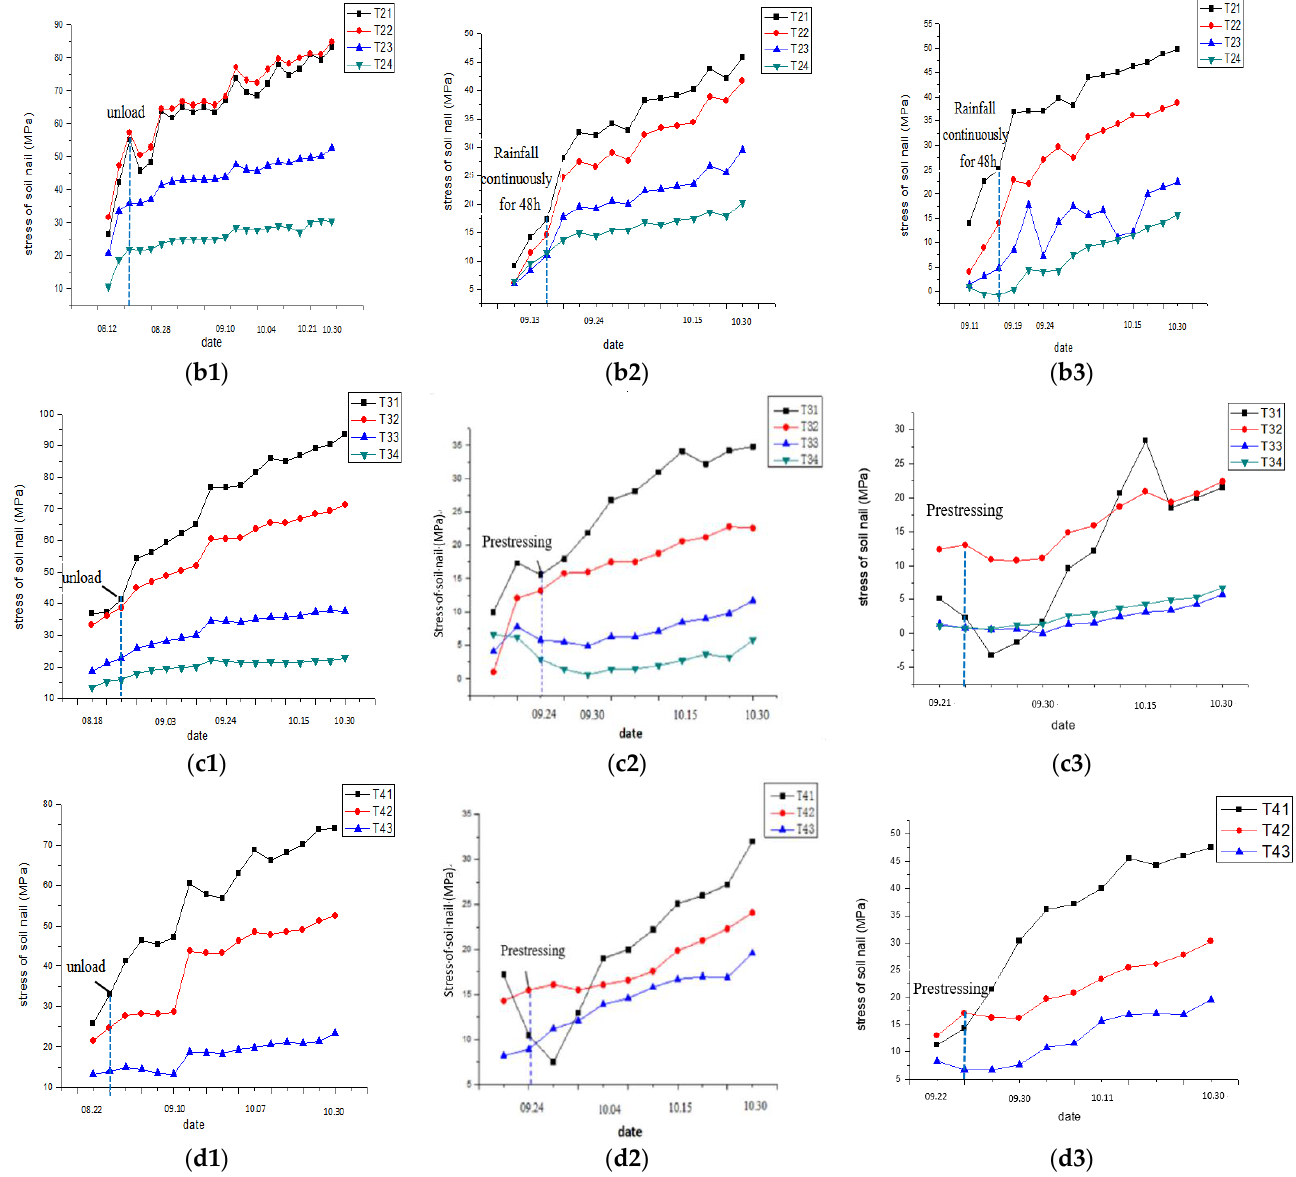
Figure 9. ( a1 ) stress of 1st row of soil nail for No. 1, ( a2 ) stress of 1st row of soil nail for No. 4, ( a3 ) stress of 1st row of soil nail for No. 5. ( b1 ) stress of 2nd row of soil nail for No. 1, ( b2 ) stress of 2nd row of soil nail for No. 4, ( b3 ) stress of 2nd row of soil nail for No. 5. ( c1 ) stress of 3rd row of soil nail for No. 1, ( c2 ) stress of 3rd row of soil nail for No. 4, ( c3 ) stress of 3rd row of soil nail for No. 5. ( d1 ) stress of 4th row of soil nail for No. 1 ( d2 ) stress of 4th row of soil nail for No. 4, ( d3 ) stress of 4th row of soil nail for No. 5. The stress-date relationship curves: ( a1 – d1 ) = No. 1 Section; ( a2 – d2 ) = No. 4 Section; ( a3 – d3 ) = No. 5 Section.